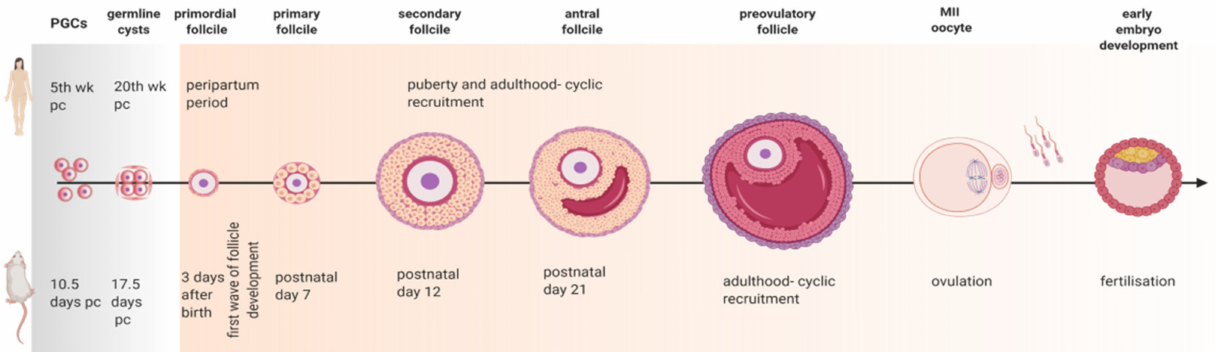
Figure 3. Diagram of folliculogenesis in mice and women. Approximately five weeks (wk) post coitum (pc) in women and 10.5 days (d) pc in mice, primordial germ cells (PGC) arrive at the genital ridge. Germline cysts start breaking 15 wk later in women and 7 days later in mice, creating the primordial follicles. During the peripartum period in woman, and within 3 days after birth in mice, primordial follicles are created. The process of follicle development in women is asynchronous, with menstrual cyclicity being started at puberty. In mice, the first wave of follicle development is detected around postnatal day 7, when the first primary follicles are originated, followed by secondary follicles detected at postnatal day 12 and early antral follicles around postnatal day 21. When mice reach sexual maturity, cyclic recruitment of follicles begins. After ovulation metaphase II (MII) oocyte is released into the oviduct where fertilization takes place, followed by early embryo development. Created with BioRender.com, accessed on 1 November